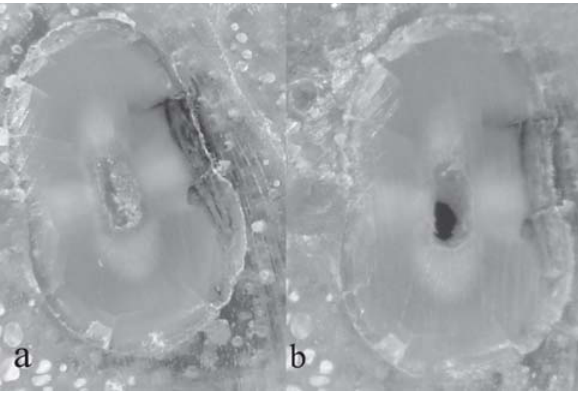
FIGURE 4- Middle third before (a) and after (b) preparation with Endo-Eze system (Score 4)